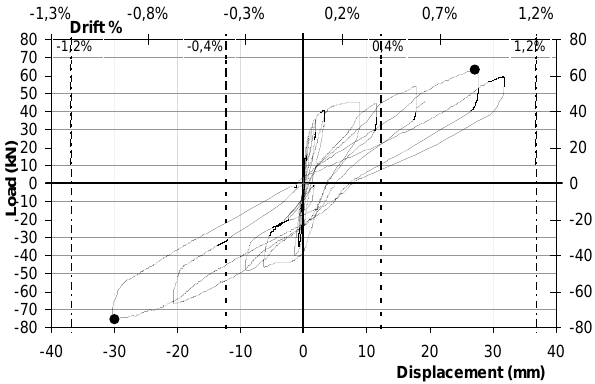
Figure 13 Hysteresis curves of specimen SPS2 Fig. 13. Hysteresis curves of specimen